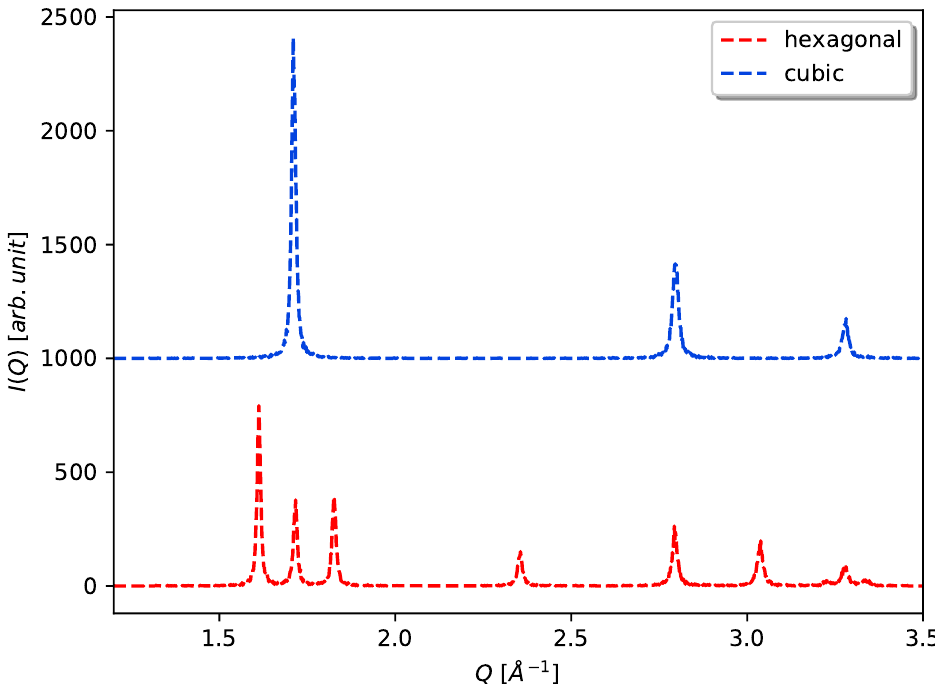
Figure A14. Ice I c and I h theoretical reference peaks estimated from FAULTS